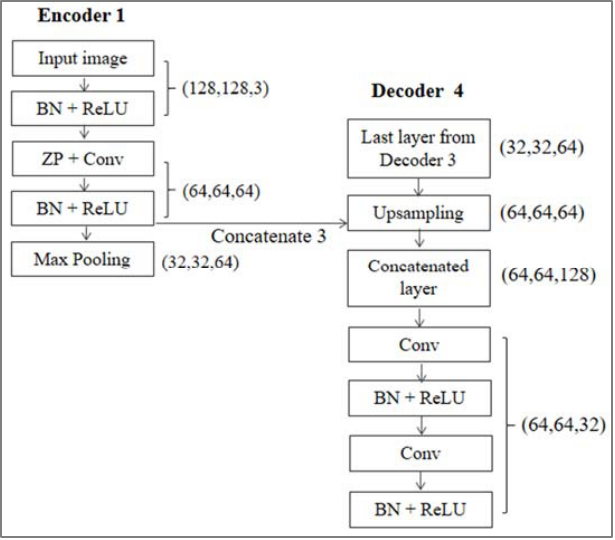
Figure 6. The basic structure of Encoder 1 and Decoder 4 of the ResNet34 ‐ UNet.